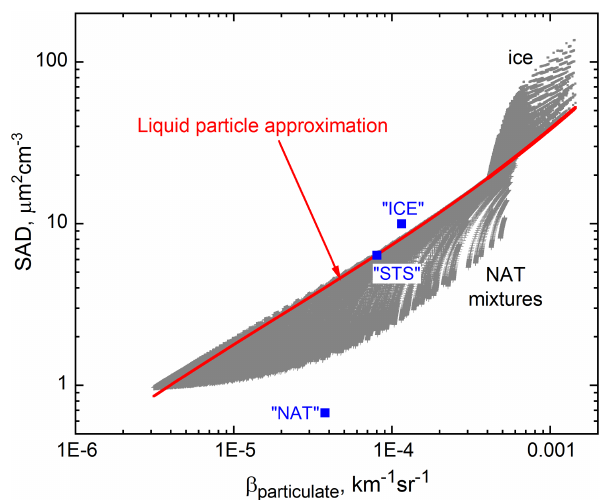
Figure 9. Theoretical particulate volume density (VD) vs. β particulate from the full suite of results for NAT mixtures and ice, compared with the liquid particle approximation. Blue symbols are computed values based on bimodal lognormal size distribution fits to in situ optical particle counter measurements within STS, NAT, and ice PSC layers (Deshler et al.,